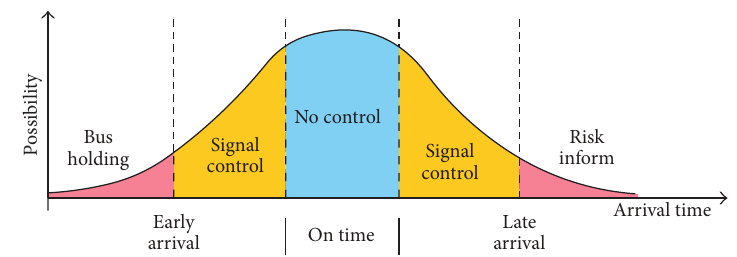
Figure 1: The conditions and corresponding